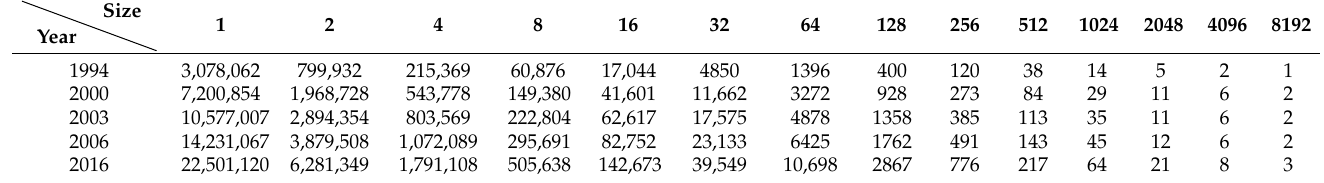
Table 4. Number of boxes in different years and box sizes for the urban clusters.